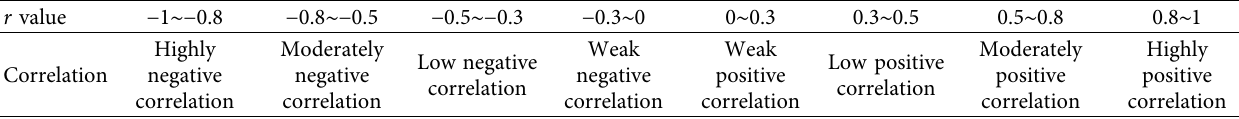
Table 2: Correlation evaluation criteria based on r value.